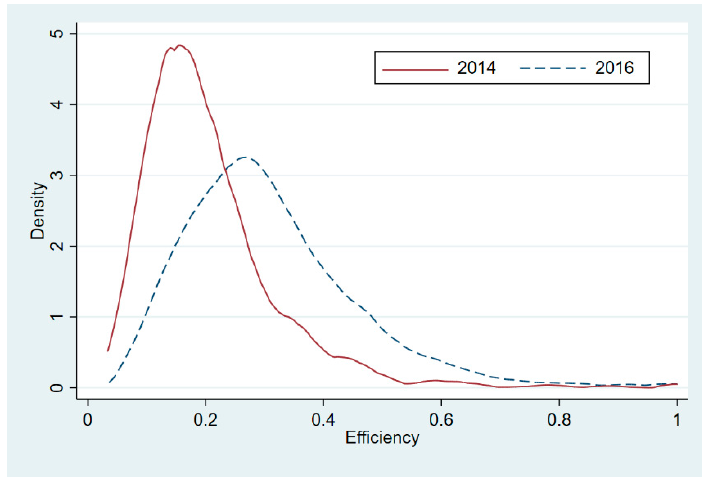
Figure 2. Kernel density estimation of household electricity efficiency.